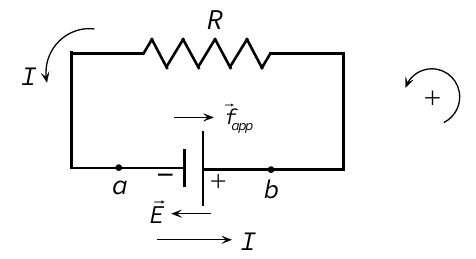
Figure 2: A battery connected to a resistive